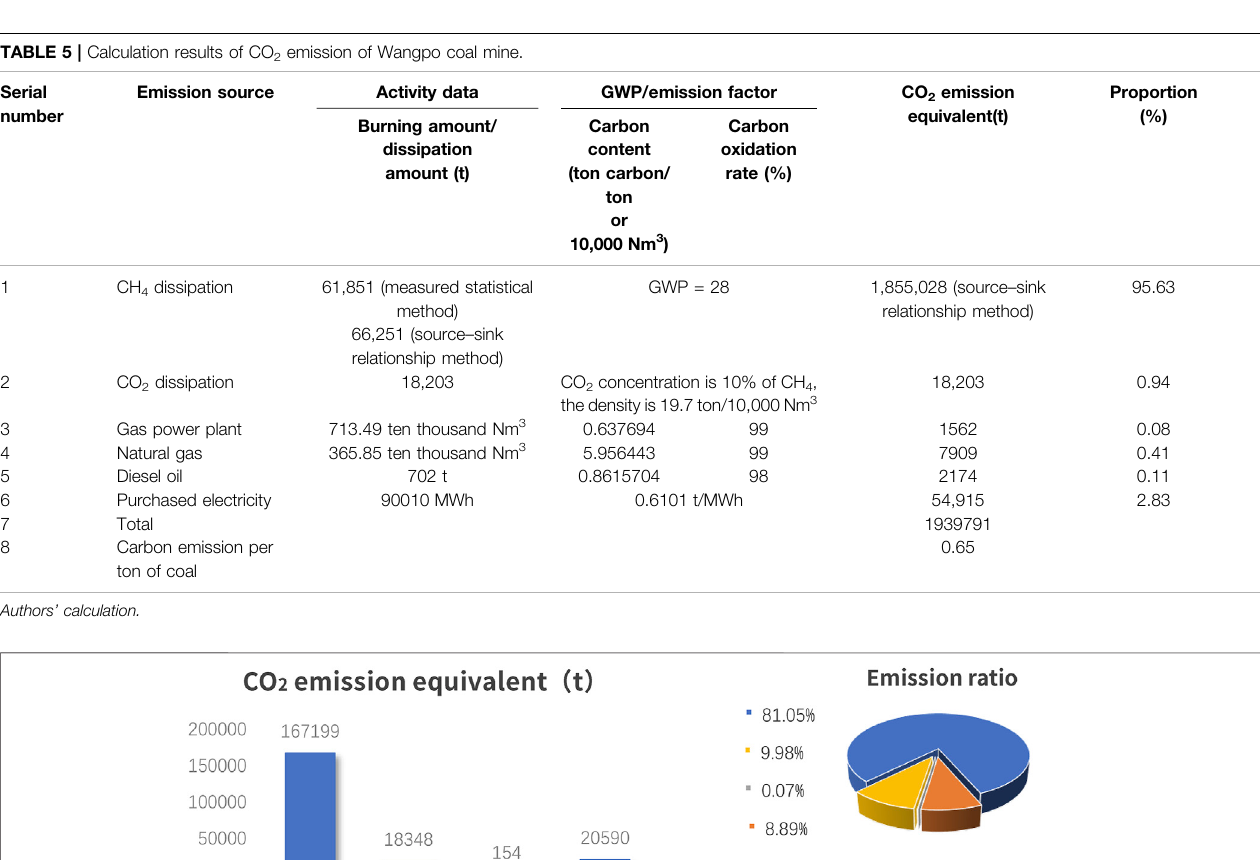
TABLE 5 | Calculation results of CO 2 emission of Wangpo coal mine.